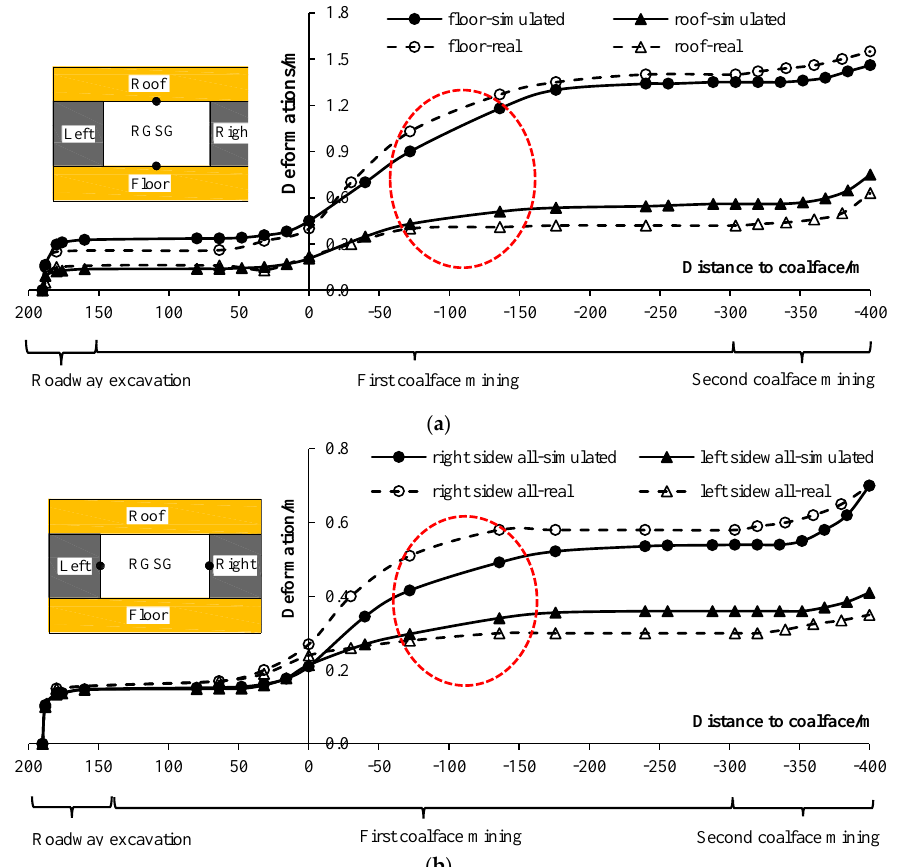
Figure 7. Deformation curves of the RGSG surrounding rock during mining process: Deformation of roof and floor ( a ); and Deformation of sidewalls ( b ).